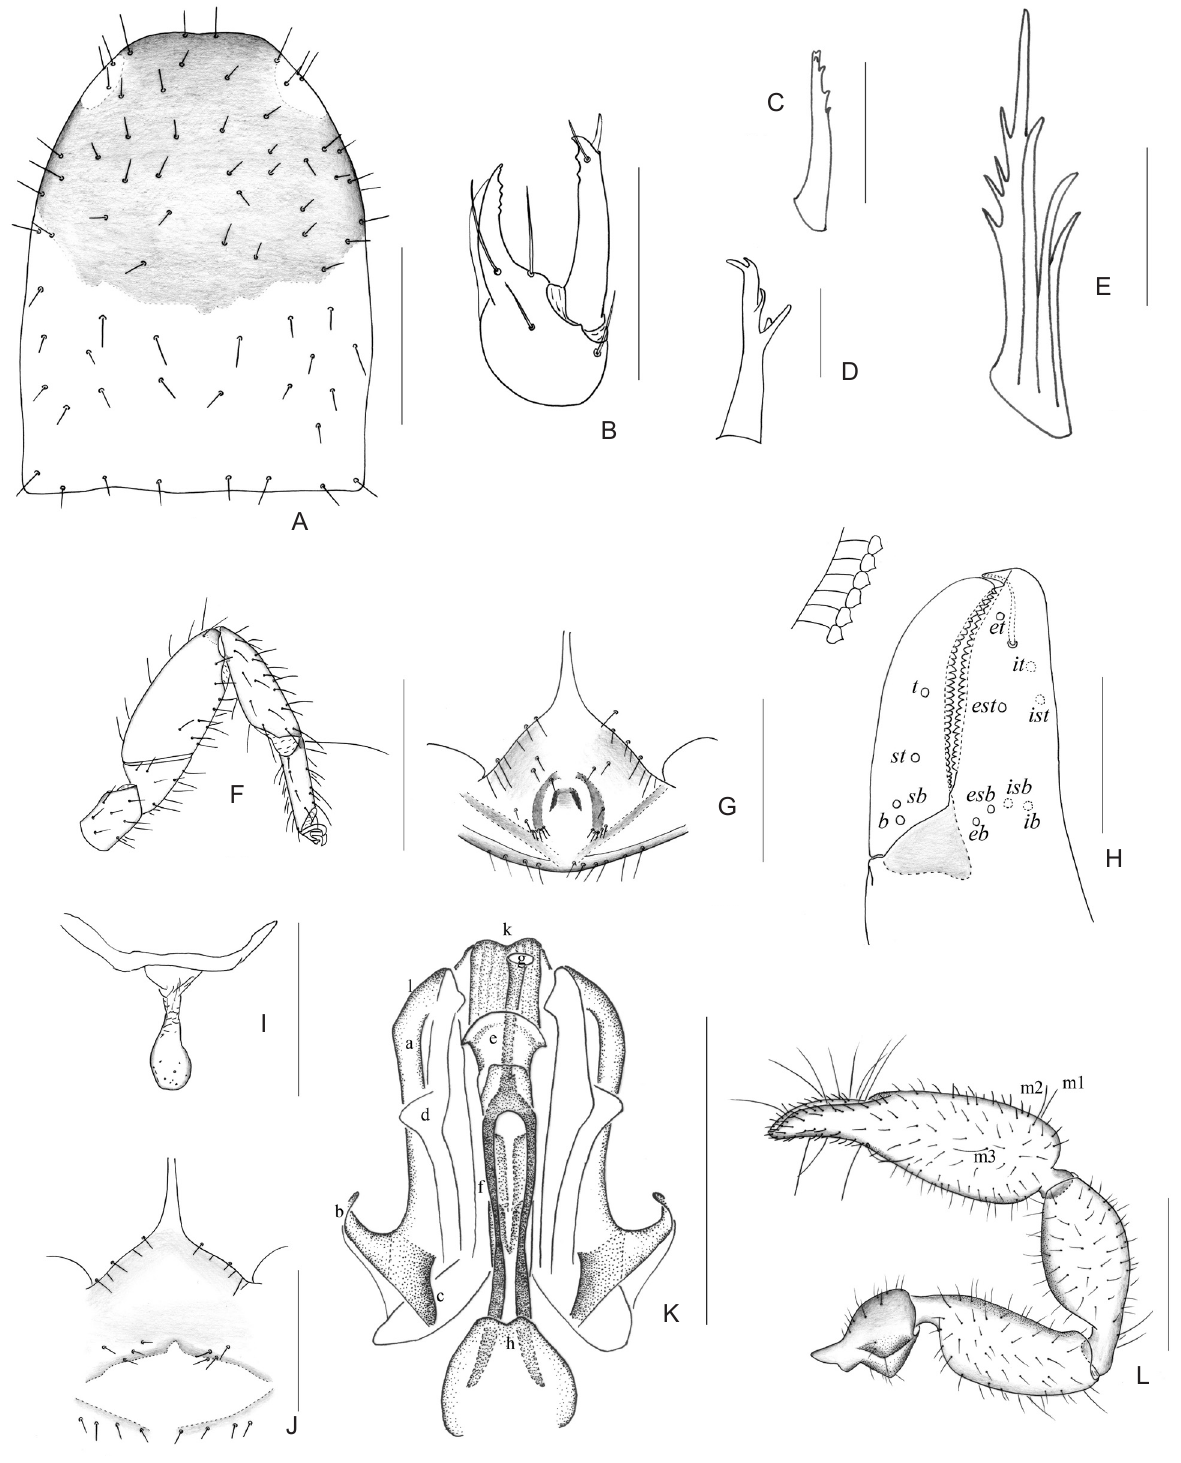
Figure 2. Atemnus limuensis sp. nov. A - Male carapace, dorsal view; B - Male chelicera, dorsal view; C - Male galea; D - Female galea; E - Rallum; F - Leg IV; G - Male genital area; H - Male chelal fingers, lateral view; I - Spermatheca; J - Female genital area; K - Male genital organ; L - Male pedipalp, dorsal view. Scale lines: 1.0mm (Figs. F, L), 0.5mm (Fig. A), 0.4mm (Figs. B, G–K), 0.05mm (Figs.